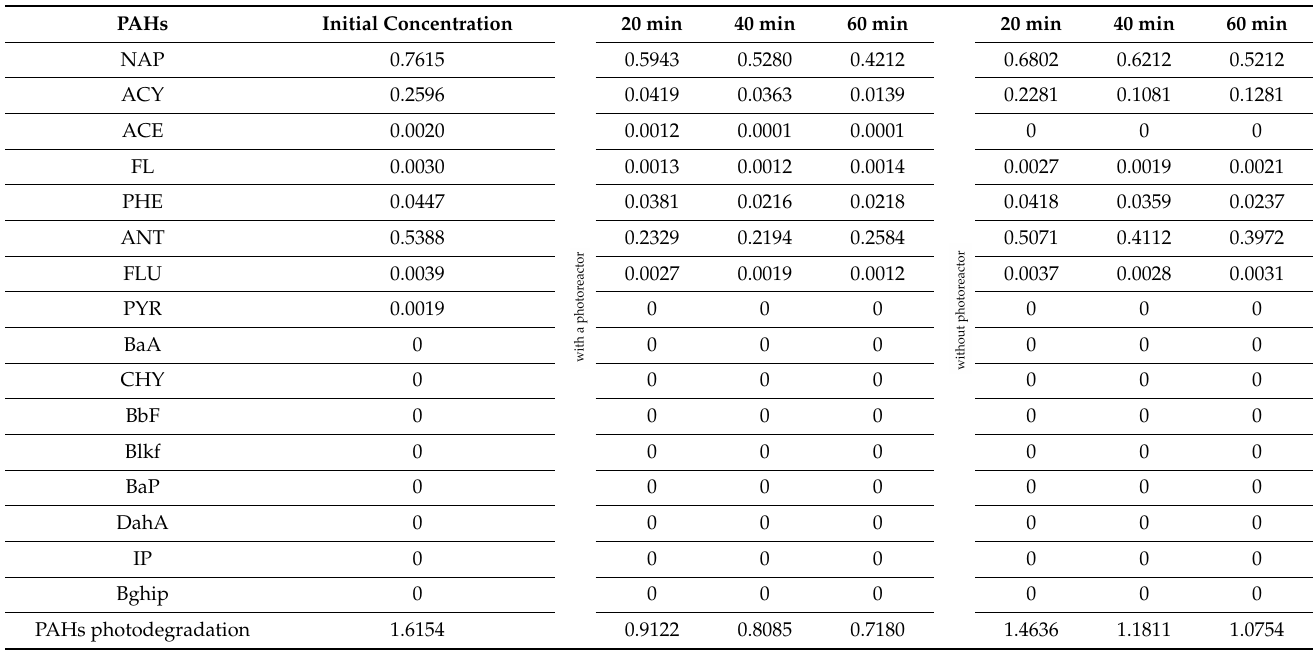
Table 4. Photodegradation of PAHs in alkaline mine drainage (concentrations in